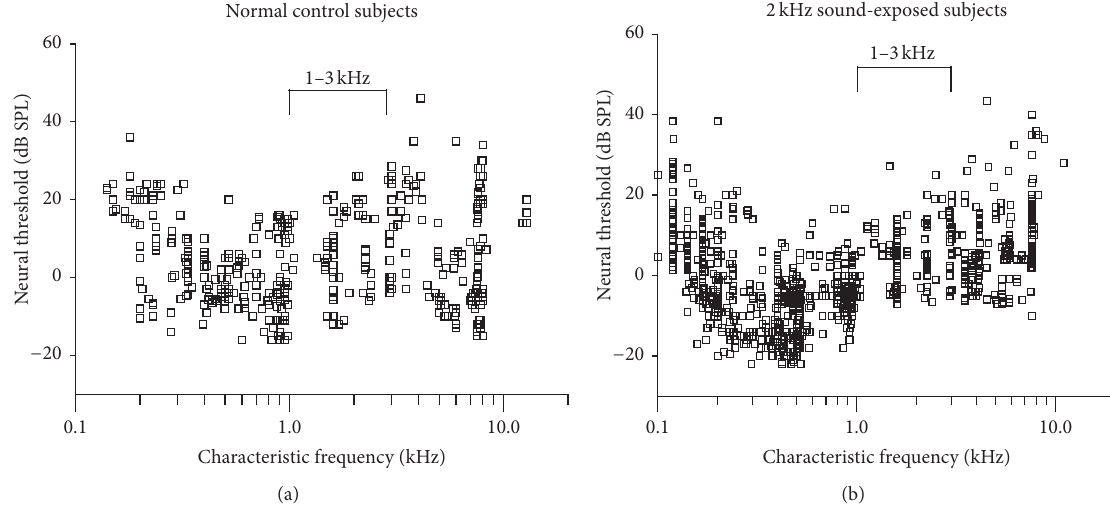
Figure 4: Minimum thresholds of IC neurons in 6 normal controls ((a); 𝑛 = 426 units) and in 5 neonatally sound-exposed animals ((b); 𝑛 = 983 units). There is no difference in neural thresholds near the frequency region (1–3kHz) of the sound-exposure stimulus.